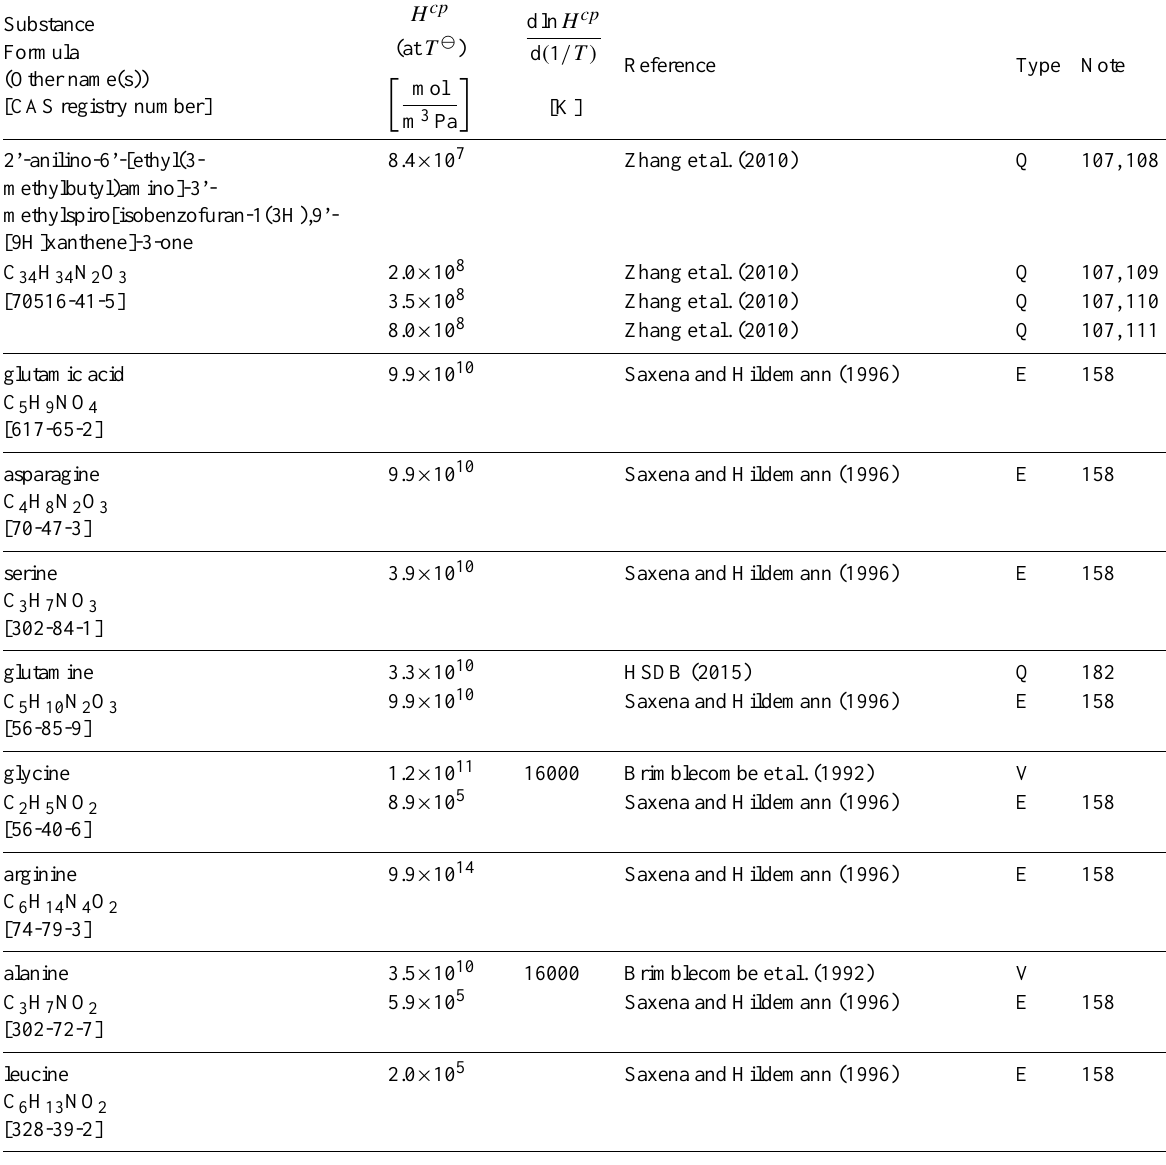
Table 6: Henry’s law constants for water as solvent